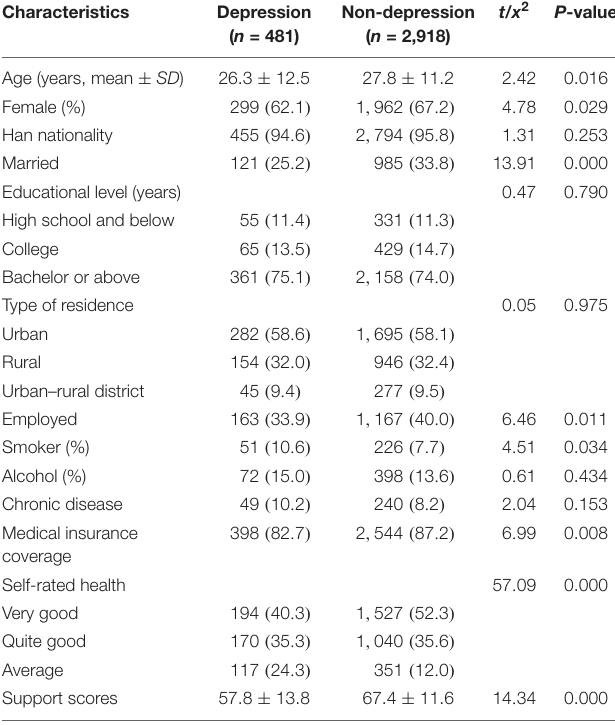
TABLE 1 | Demographic and behavior characteristics of participants with or without depressive